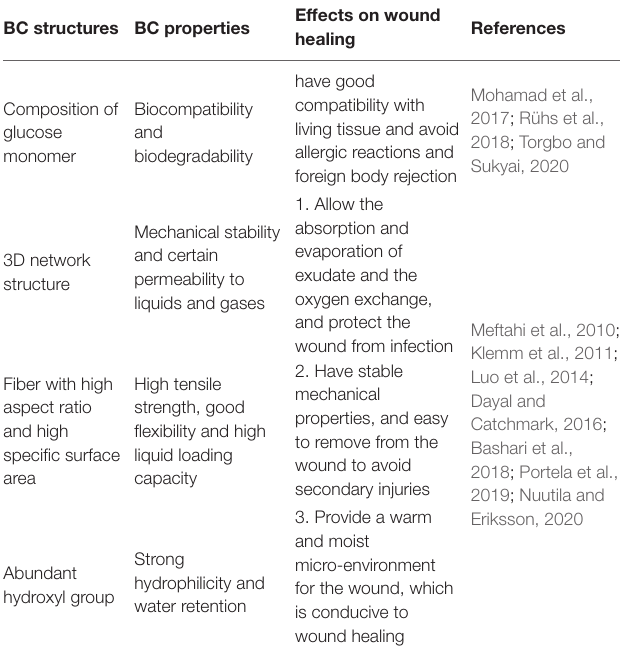
TABLE 1 | The relation among BC structures, BC properties, and wound